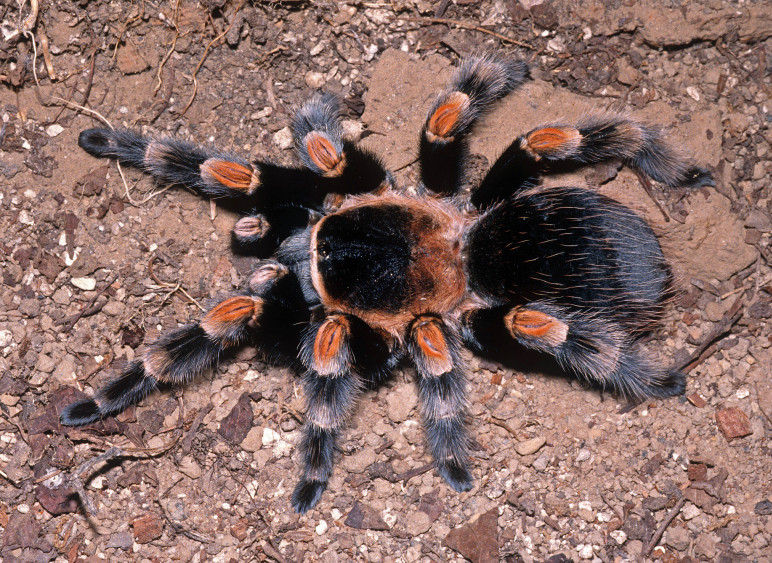
Brachypelma
smithi (F. O. P.-Cambridge, 1897) female dark morphotype near Ixtapa, Guerrero state, Mexico. Photo: Rick C. West.